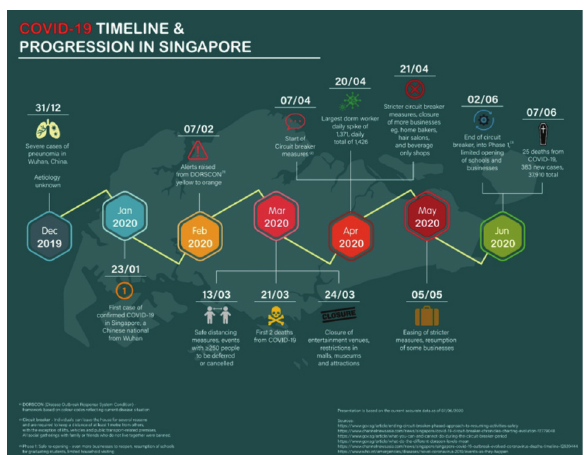
Further safe distancing measures in the lift itself, limiting Fig. 2: maximum lift occupancy to maintain social distancing.